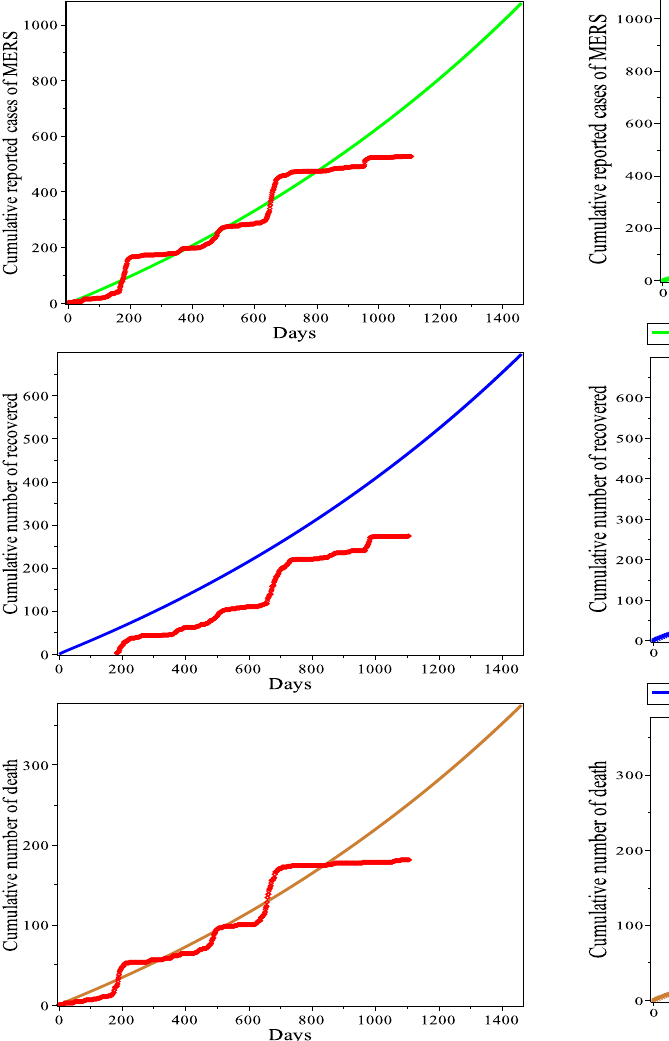
Fig. 3: Baseline model simulations of cumulative reported cases of MERS (T - green curve); cumu- lative number of recovered (M - blue curve); and cumulative number of death (B - brown curve). The red curves are the observed data for 1107 days.